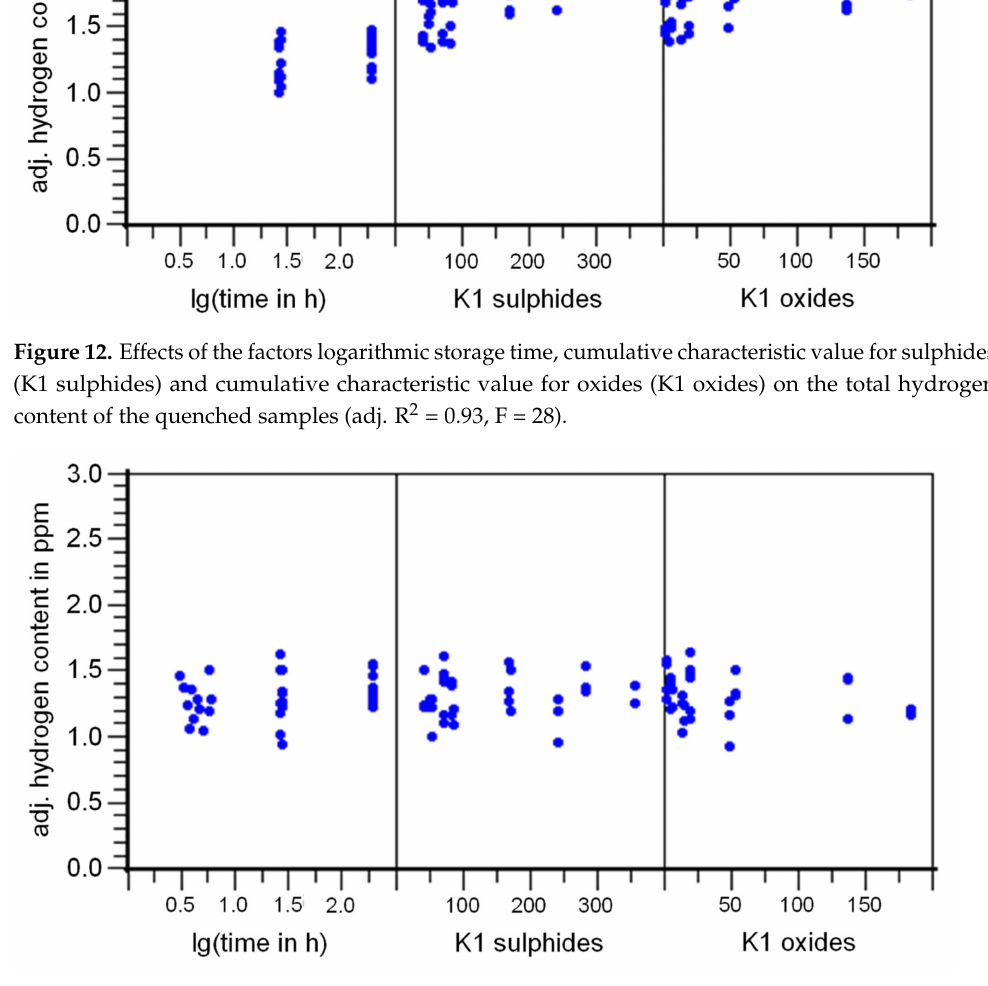
Figure 13. Effects of the factors logarithmic storage time, cumulative characteristic value for oxides (K1 oxides) and cumulative characteristic value for sulphides (K1 sulphides) of the hydrogen content of the samples tempered at 180 ◦ C/1 h (adj. R 2 = 0.06, F =